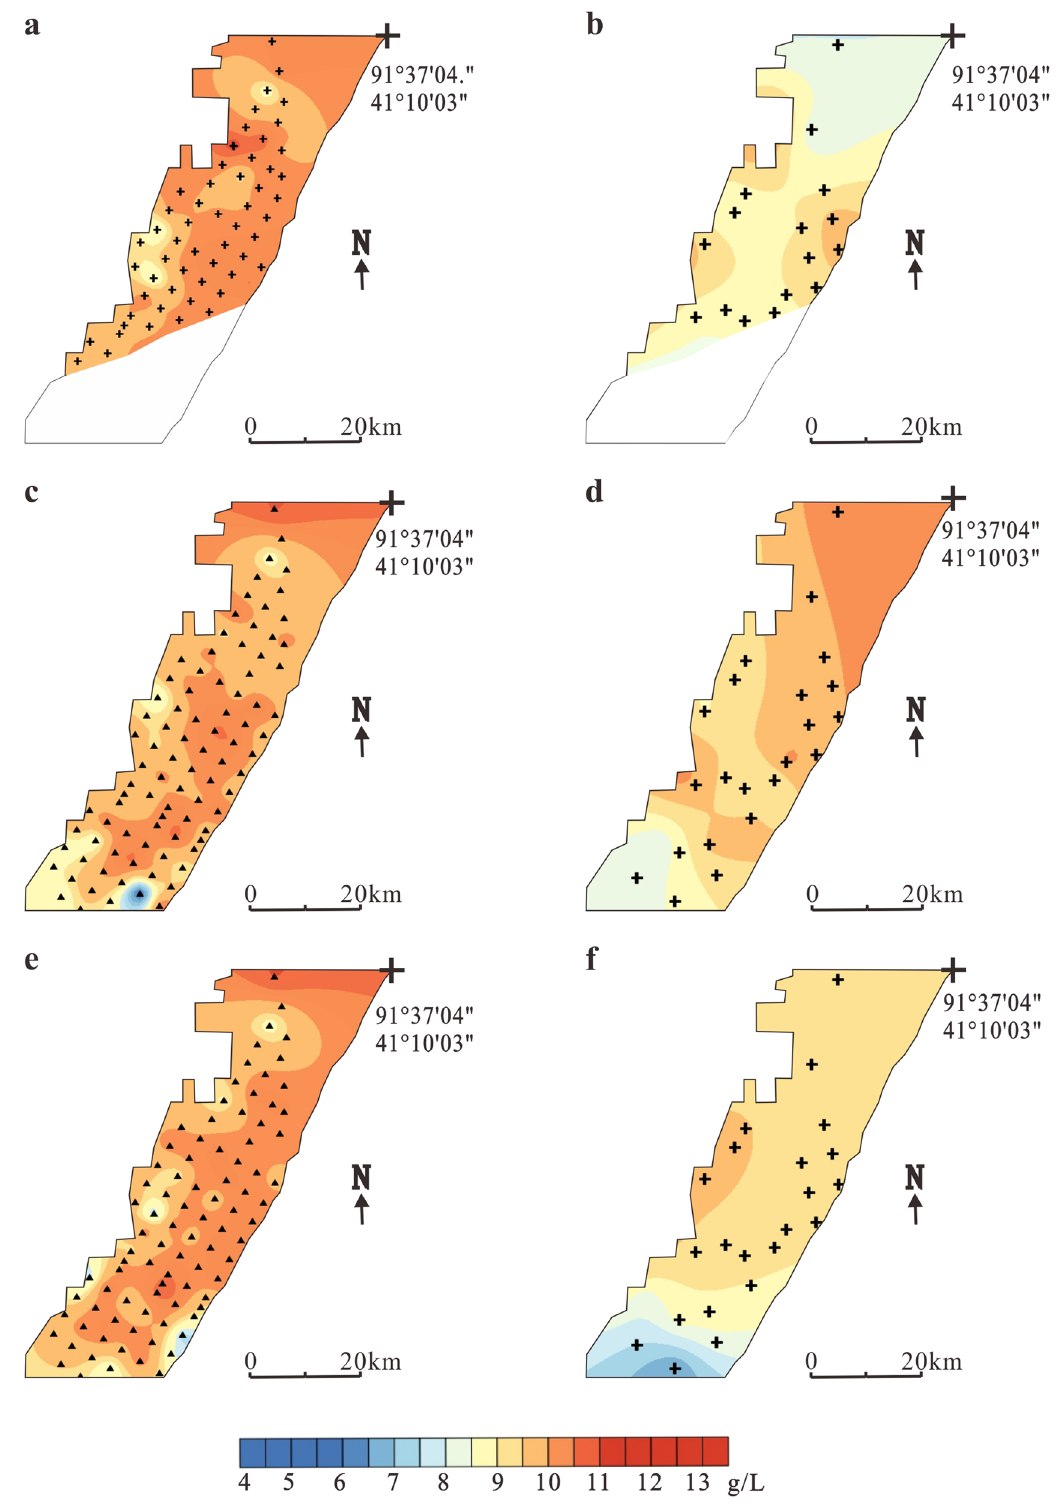
Figure 6. Temporal and spatial variations in K + content of different brine layers in Tenglong platform. ( a ) Layer W 1 in 2009, ( b ) Layer W 1 in 2017, ( c ) Layer W 2 in 2009, ( d ) Layer W 2 in 2017, ( e ) Layer W 3 in 2009 and ( f ) Layer W 3 in 2017. The black crosses indicate observation holes